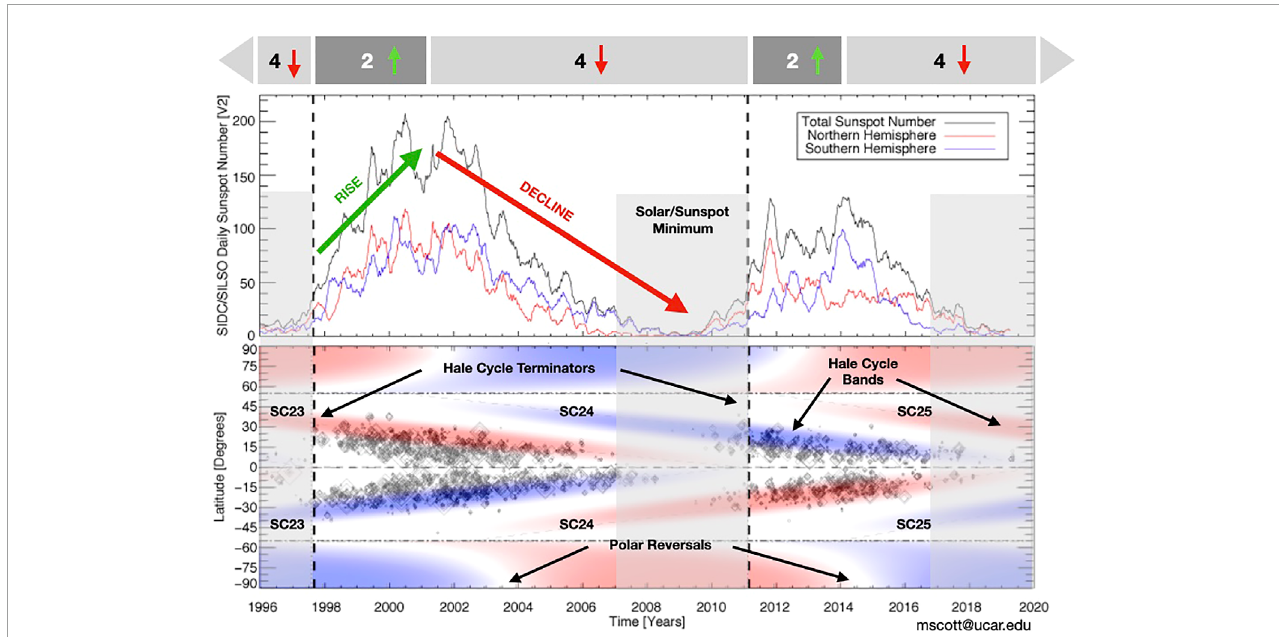
FIGURE 1 A contextual infographic to illustrate how the landmarks of the sunspot cycle tie to the underlying Hale Cycle, as per M2014 and following work. The upper panel illustrates the hemispheric and total sunspot numbers where green and red arrows are used to designate the rising and declining phases of the sunspot cycle, respectively. In the lower panel we illustrate the appearance of the Hale Cycle activity bands with the observed latitudinal distribution of sunspots. There are four sets of Hale cycle bands visible in this time frame: those hosting SC22 through SC25. Periods of sunspot minima are shown as gray shaded areas that span both panels. The vertical dashed lines denote the times of the Hale Cycle termination events at the equator. Along the top of the infographic the number of Hale Cycle bands present between ± 55° (horizontal dot-dashed lines) is indicated along with the correspondingly colored arrows for the ascending and declining phases of the sunspot cycles in this